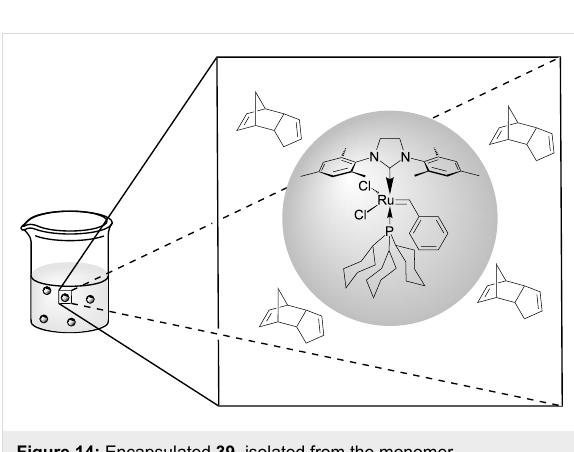
Figure 14: Encapsulated 39 , isolated from the